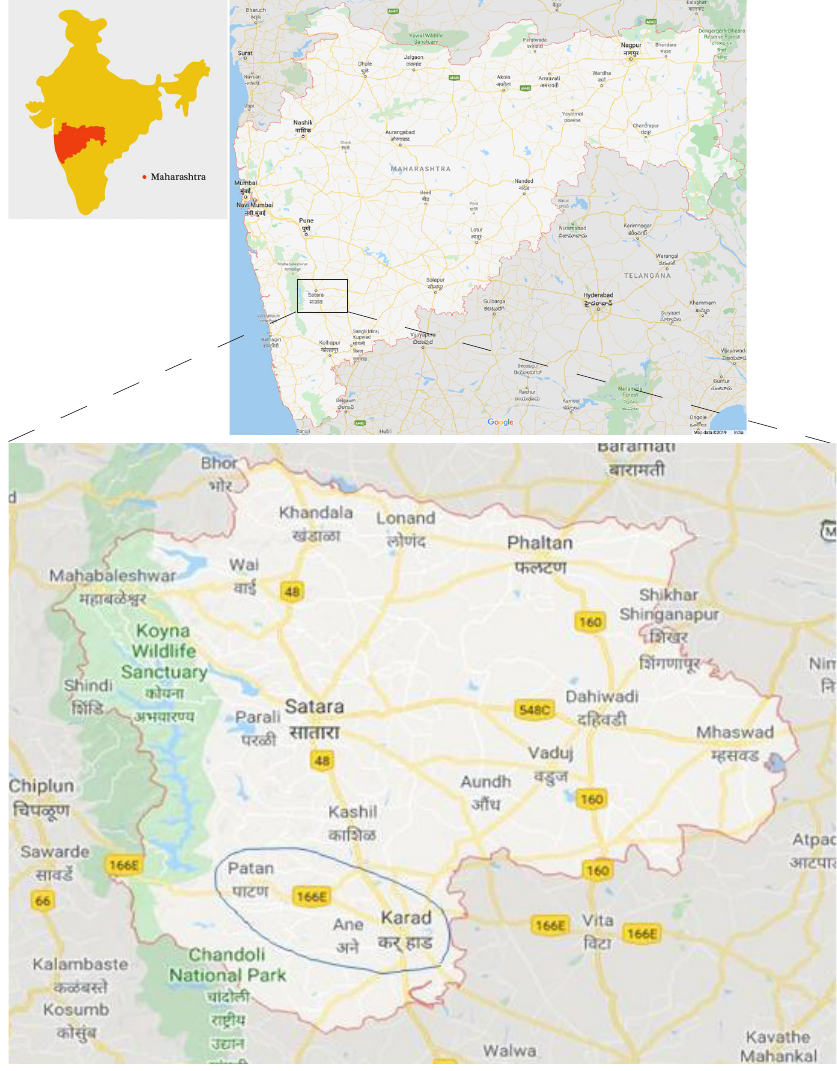
Figure 1. Study area—location of Karad and Patan Tahasils of Satara District. Source: Google